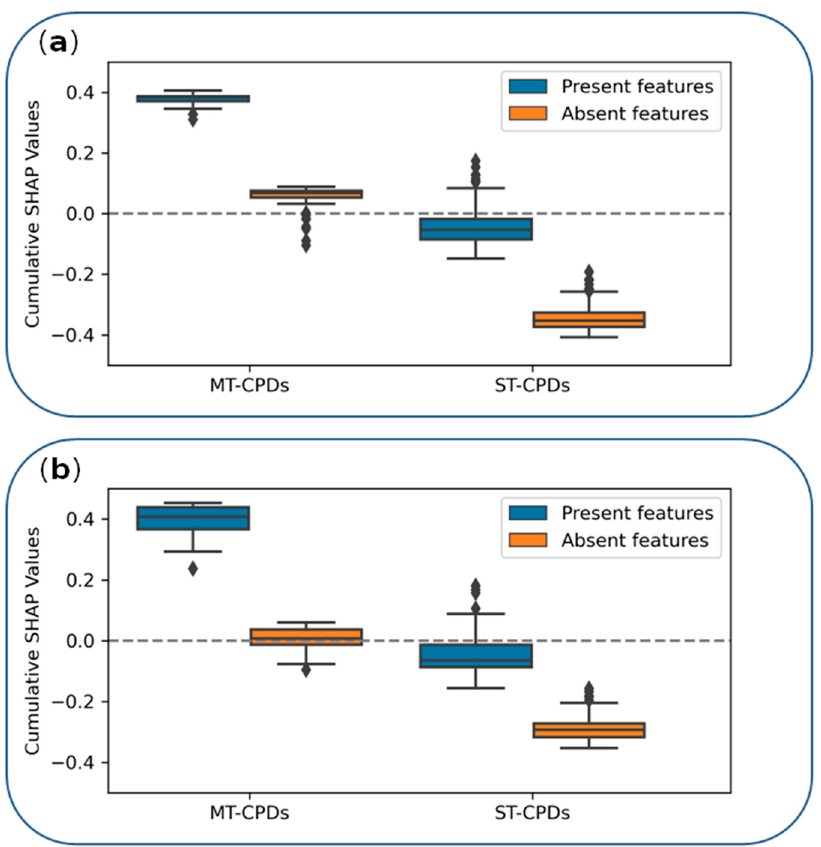
Figure 3. Feature contributions. Boxplots report the distributions of cumulative SHAP values of features present (blue) or absent (orange) in correctly predicted MT- or ST-CPDs. ( a , b ) show the results for triplet 1 and triplet 2, respectively.